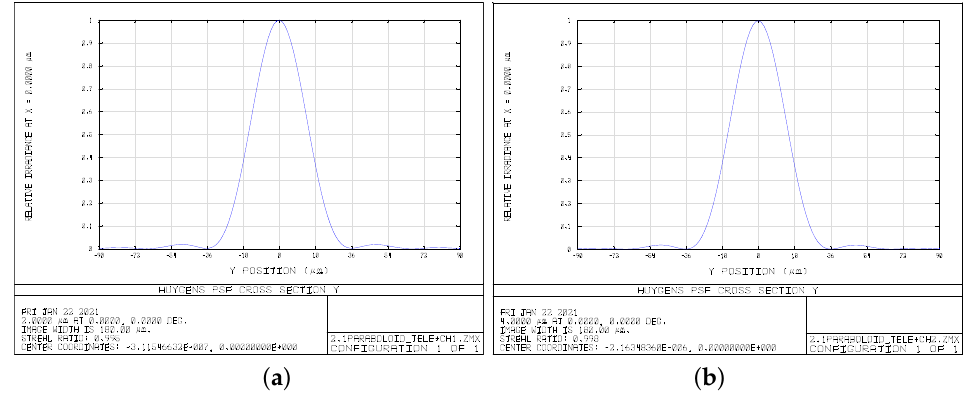
Figure 12. PSF curves for ( a ) CH1 and ( b ) CH2 in λ min . Optical system of two channels was designed to achieve 2-pixel full width at half-maximum (FWHM) sampling when pixel size is 18 µ